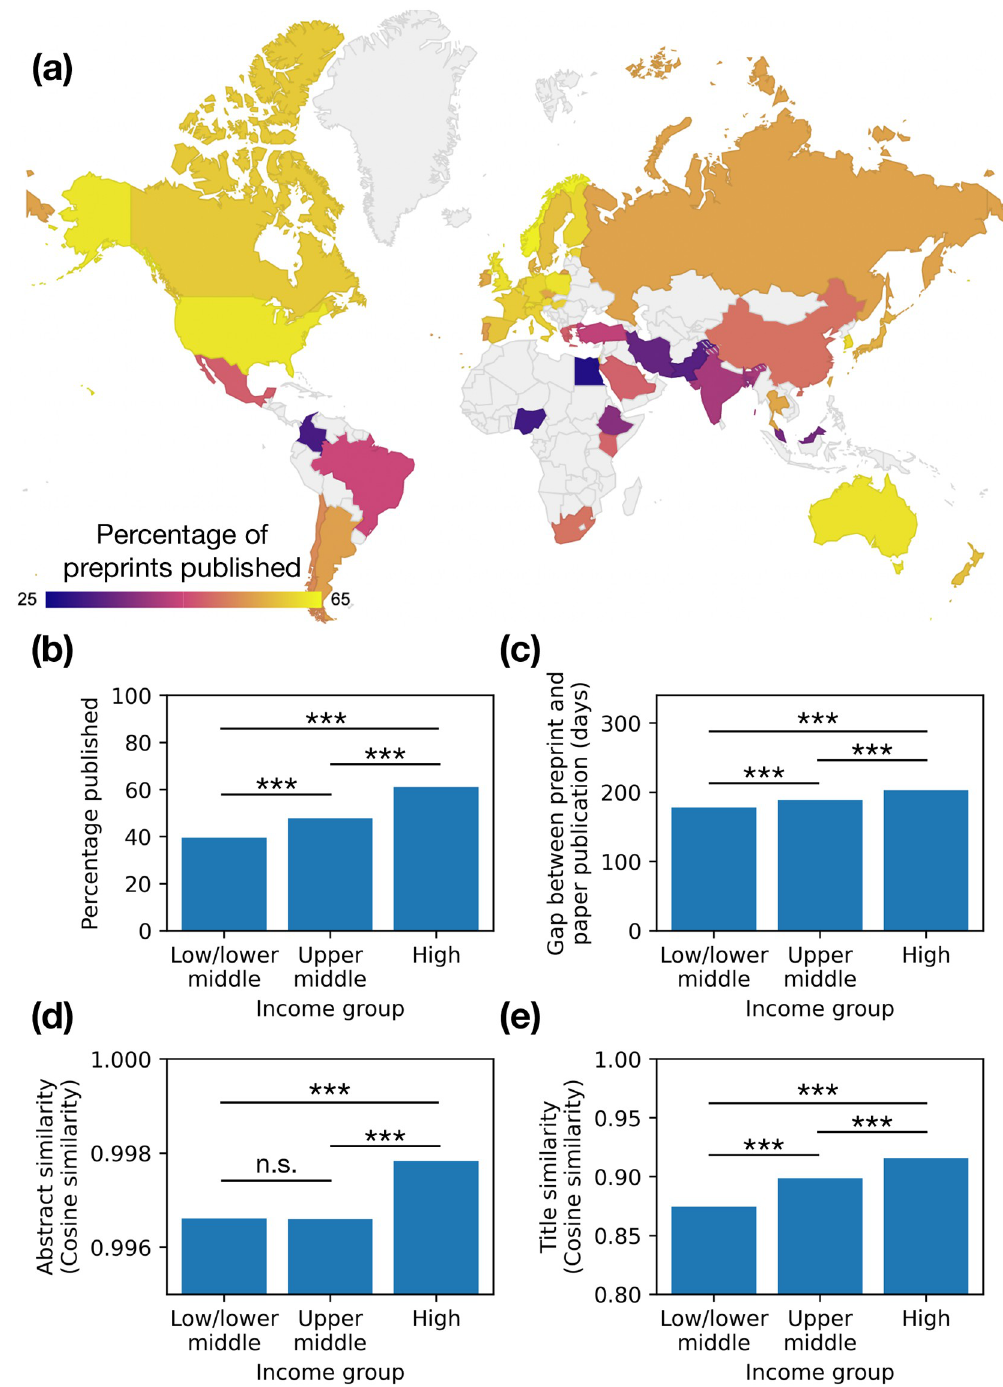
Fig 4. Country level preprint analysis. (a) Map of the rate of preprint publication for the top 50 research-producing countries. (b) Preprint publication rate of World Bank country income group classifications. (c) Time gap between preprint posting and paper publication, in days, for income groups. (d) Median abstract similarity between preprint and paper for income groups. Horizontal line shows median of all published preprints. (e) Mean title similarity between preprint and paper for income groups. Horizontal line shows mean of all published preprints. ��� p < 0.001, n.s. not significant.